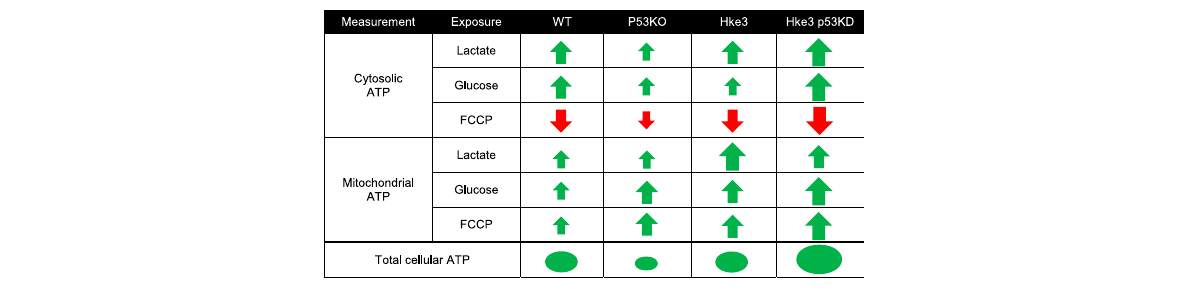
TABLE 2 Summary of cytosolic, mitochondrial and overall cellular ATP